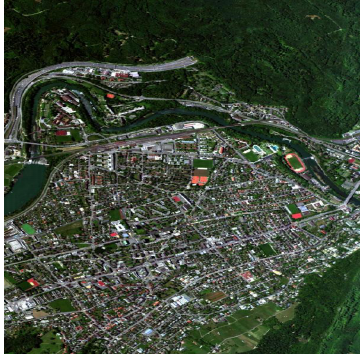
Figure 3: Study area, Baden,